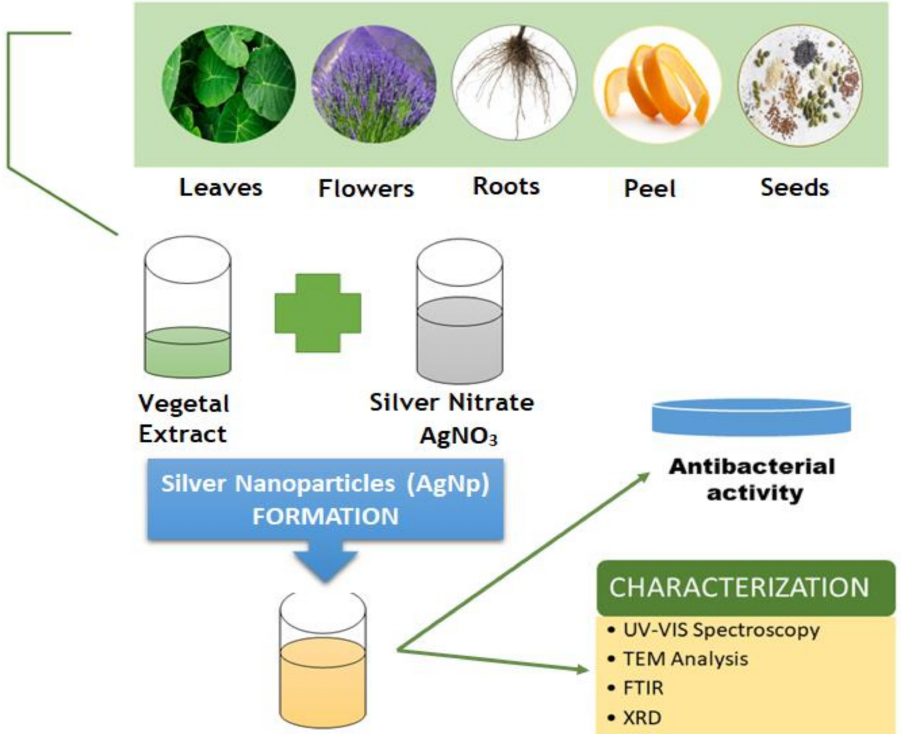
Figure 6. Schematic representation of silver nanoparticles green synthesis.